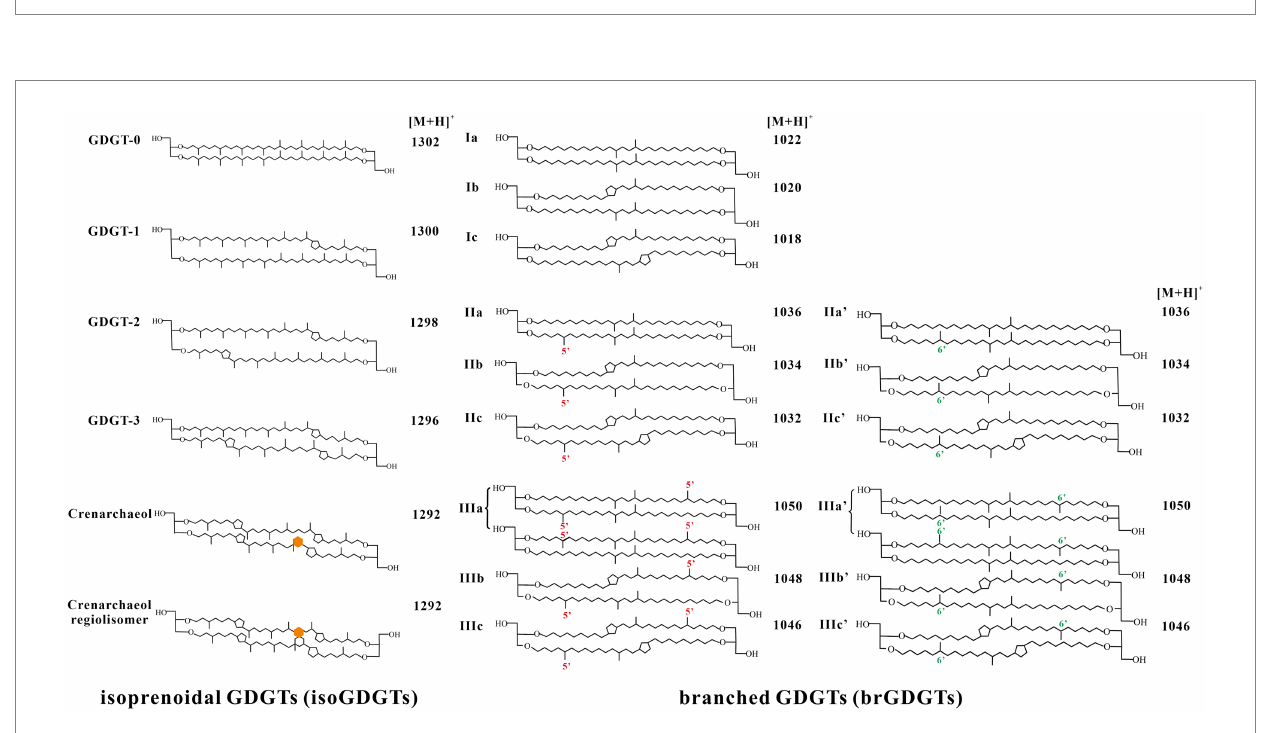
FIGURE 2 Structures of archaeal isoGDGTs and bacterial